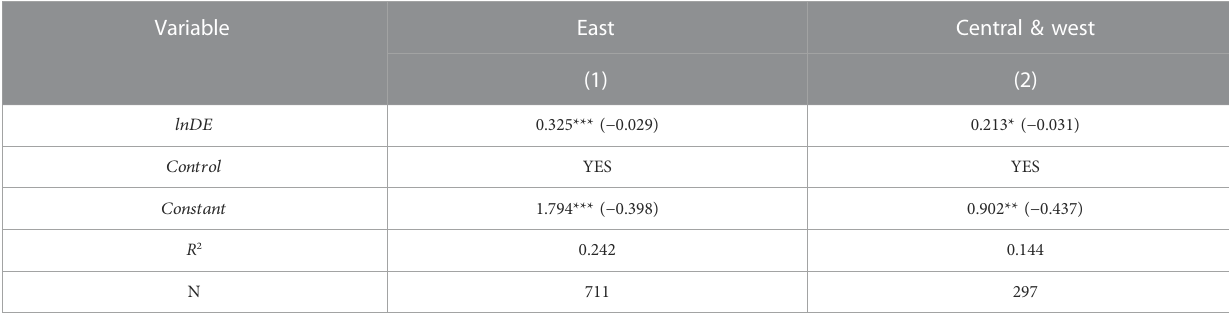
TABLE 6 Basic regression results by